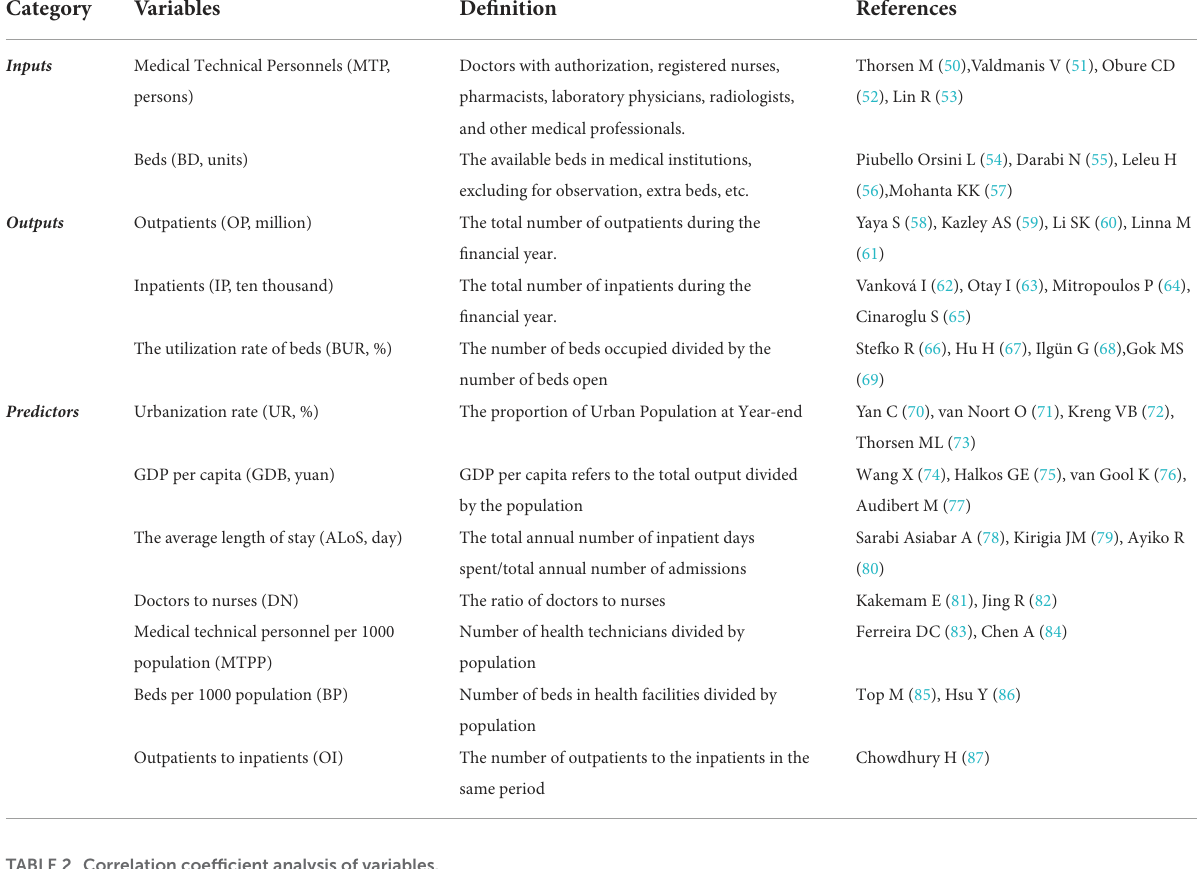
TABLE 1 Study variables and data.